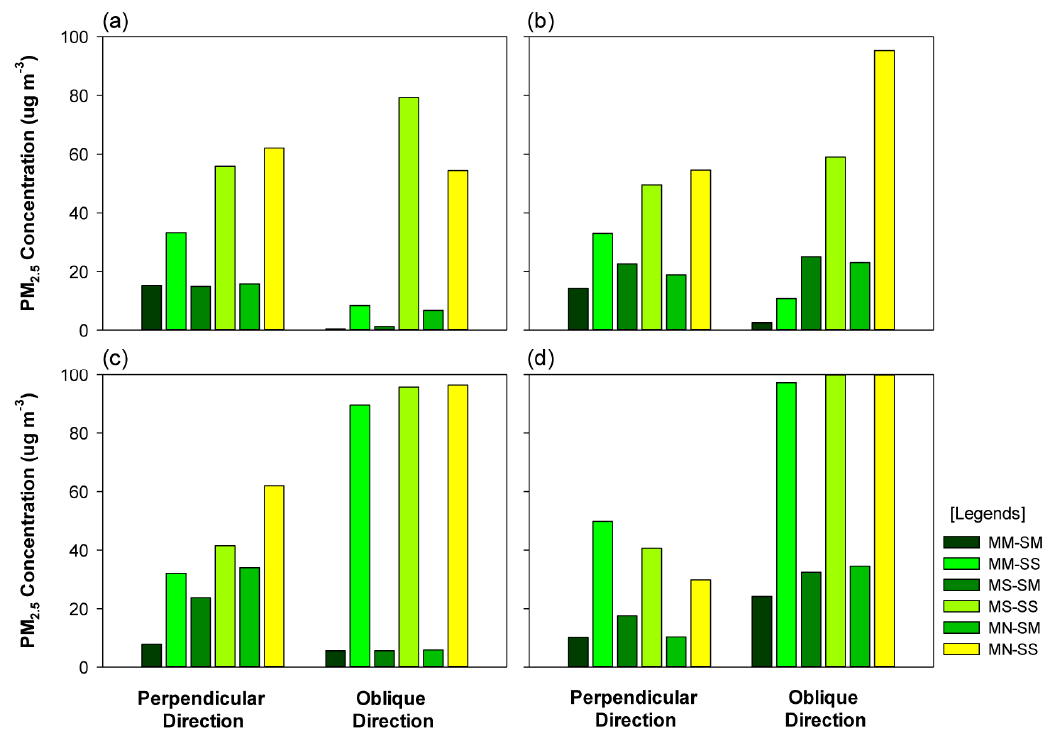
Figure 11. Graphs portraying the particulate matter (PM 2.5 ) concentration at each site based on the changes in wind direction: ( a ) pedestrian road (P-1), ( b ) leeward motor road (P-2), ( c ) windward motor road (P-3), and ( d ) windward pedestrian road (P-4).